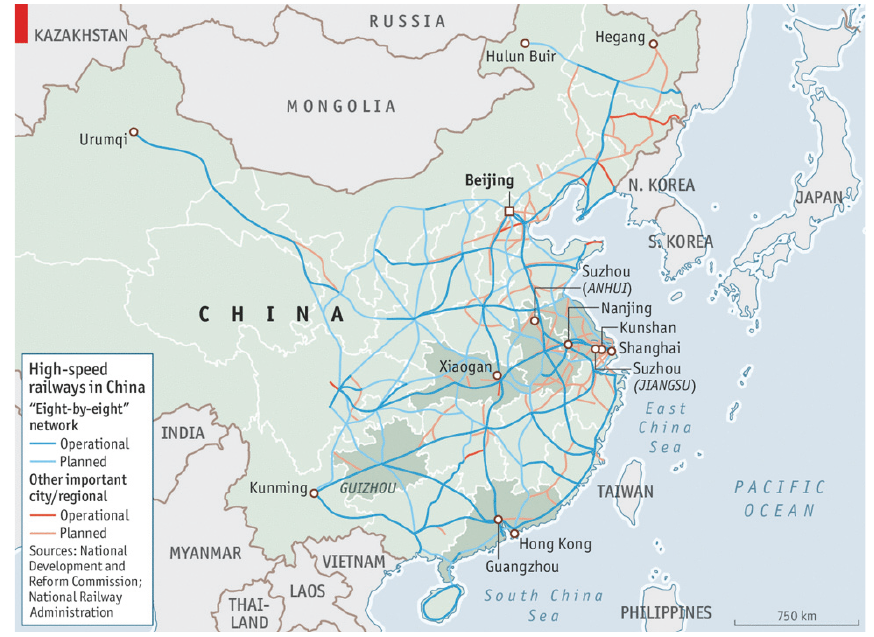
Figure 1: High-speed rail network in China (from